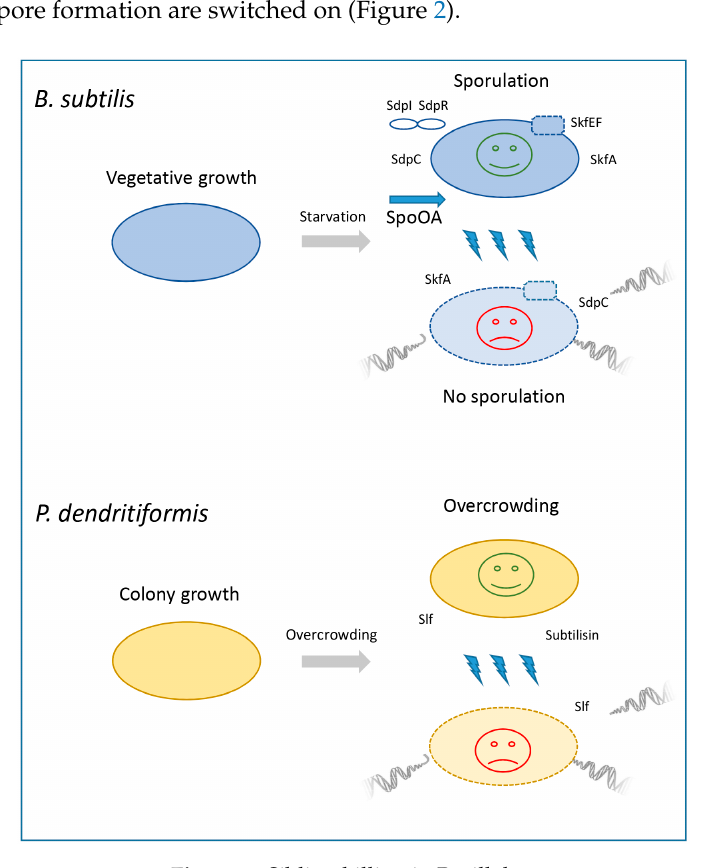
Figure 2. Sibling killing in Bacillales.